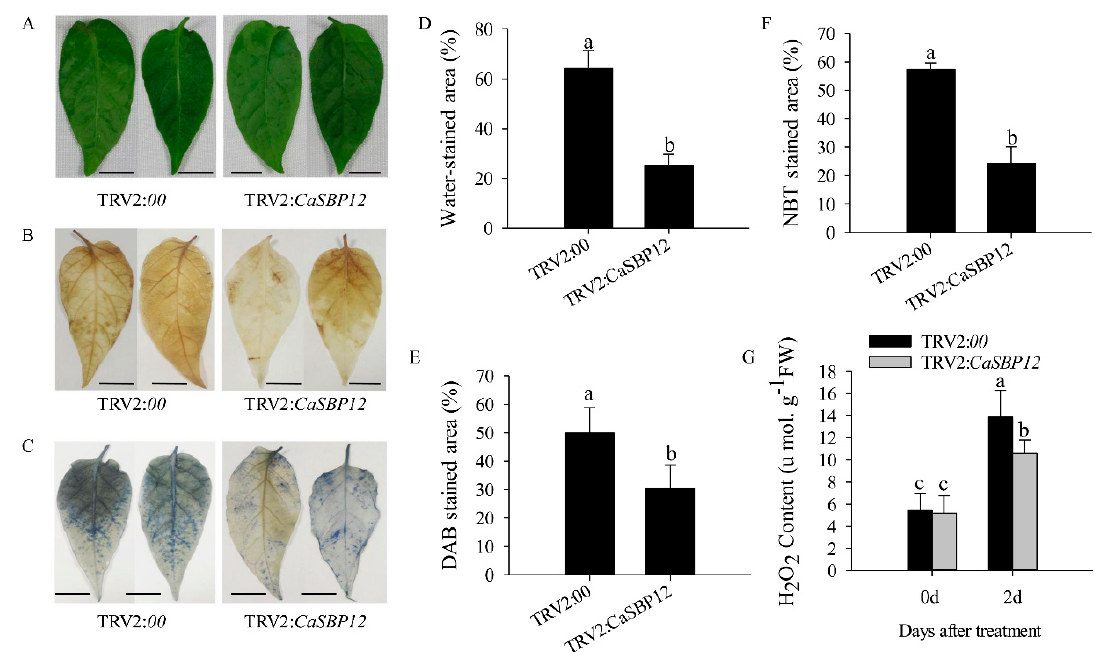
Figure 3. DAB and NBT staining of silenced plants and the phenotypes of the detached leaves of silenced plants. ( A ) Phenotypes of the detached leaves of CaSBP12-silenced and control plants after 2 days of treatment with 400 mM NaCl. ( B ) DAB staining in leaves of CaSBP12-silenced and control plants after 2 days of treatment with 400 mM NaCl. ( C ) NBT staining in leaves of CaSBP12-silenced and control plants after 2 days of treatment with 400 mM NaCl. ( D ) Water-stained area (%) of the detached leaves of silenced plants after 2 days of treatment with 400 mM NaCl. ( E ) The DAB stained area (%) of the detached leaves of silenced plants after 2 days of treatment with 400 mM NaCl. ( F ) The NBT stained area (%) of the detached leaves of silenced plants after 2 days of treatment with 400 mM NaCl. ( G ) The H 2 O 2 content of the detached leaves of silenced plants after 2 days of treatment with 400 mM NaCl. d: days. The black line is used as a scale bar (length 0.75 cm). Bars with di ff erent letters indicate significant di ff erences at p ≤ 0.05. Mean values and SDs at least for three biological replicates are shown.